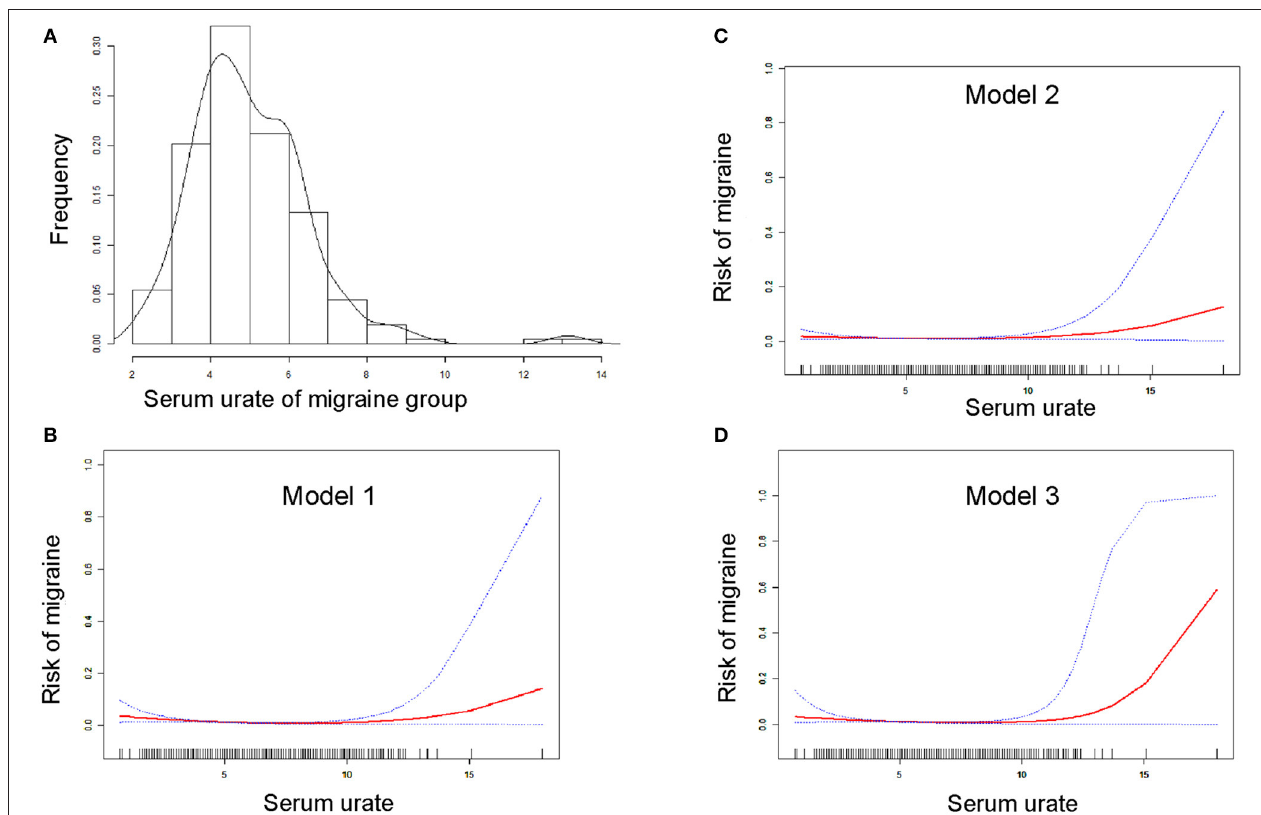
FIGURE 2 | Smooth curve fitting for the relationship between serum urate and the risk of migraine. (A) Shows the bell curve of serum urate of migraine group. (B–D) Show the smooth curve fitting for the relationship between serum urate and the risk of migraine. The horizontal axis presents serum urate (continuous variable), and the ordinate presents the risk of migraine (0 = non-migraine, 1 = migraine). Red line means smooth curve fitting between serum urate and migraine. Blue bands mean 95% of confidence interval ( CI ) from the fit. Model 1 (B) was adjusted for nothing. Model 2 (C) was adjusted for age, gender, race, and data release cycle. Model 3 (D) was adjusted for age, gender, race, data release cycle, blood albumin, blood globulin, blood total protein, hemoglobin, blood urea nitrogen, ferritin, serum iron, usage of NSAIDs, usage of opioid, usage of triptans, usage of antiepileptic drugs, usage of antidepressants, usage of β -blockers, usage of Ca 2 + blockers, and usage of antihistamines.